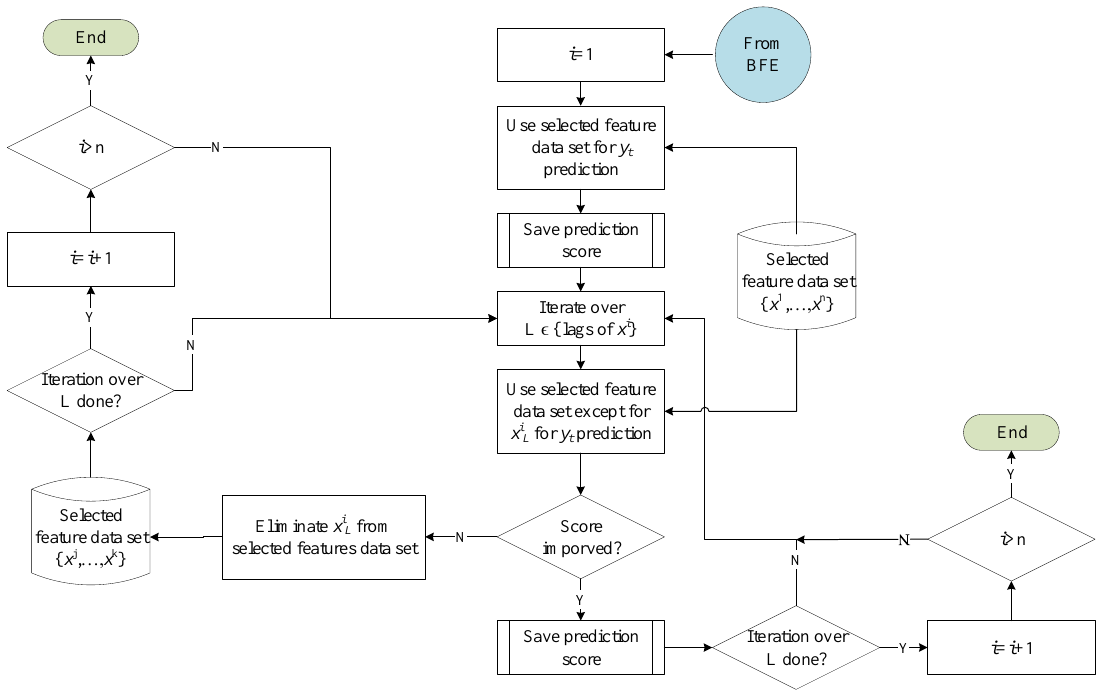
Figure 9. Backward feature elimination